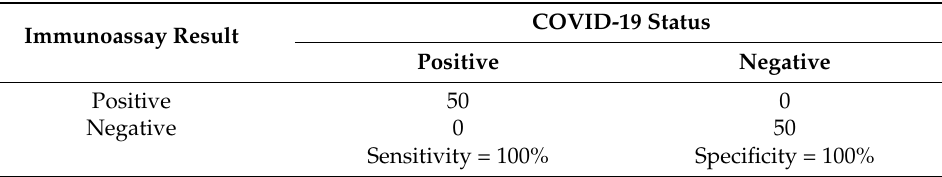
Table 2. Validation immunoassay data (Cohort 2). Confusion matrix showing the number of severe COVID-19 cases ( n = 50) and pre-pandemic controls ( n = 50) who gave a positive or negative assay result on the microarray platform, allowing calculation of clinical sensitivity and